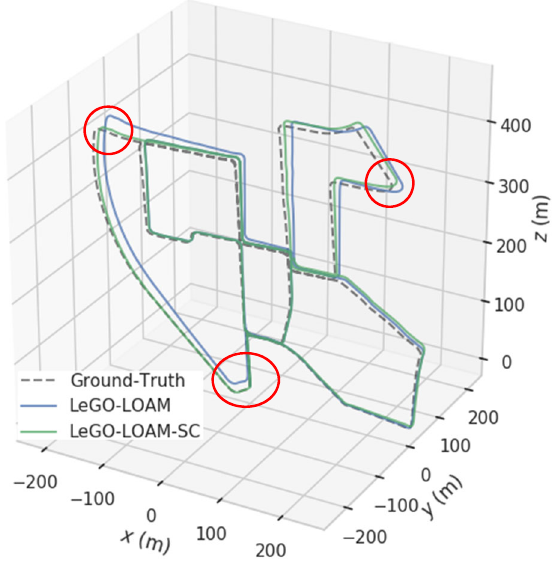
Figure 7. Comparison of tracks diagram obtained by LeGO-LOAM-SC and LeGO-LOAM.